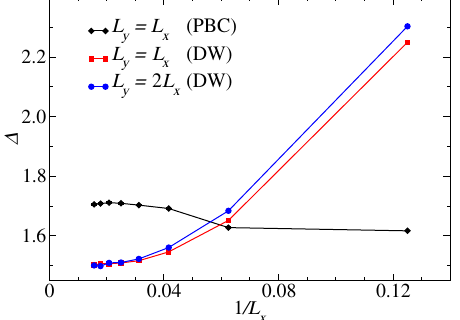
FIG. 24. Singlet-triplet gaps of the nonrandom system at J ¼ 0 , Q ¼ 1 with and without a domain wall. The bulk VBS gap corresponds to the L → ∞ limit of the results for the system with periodic boundaries. For systems with a domain wall (illustrated in Fig. 23) induced by modified open boundaries in the horizontal =L direction, two different aspect ratios L are considered as a y x → ∞ . FIG. 25. Visualization of the local susceptibility for the same check of a unique intrinsic gap of the domain wall when L x coupling realization of the random- Q model for which the VBS domains are illustrated in Fig. 8 and with the same hand-drawn domain boundaries (turquoise curves). The values of the suscep- tibility defined in Eq. (15) are rescaled so that the maximum is 1, and the color coding is shown on the bar on the right side. Note that in some cases, a nexus of four domain walls is dark because it does not correspond to a spinon. This can be seen by comparing with Fig. 8, where it can be seen that the cases in question involve only two different domains (thus, no spinon is